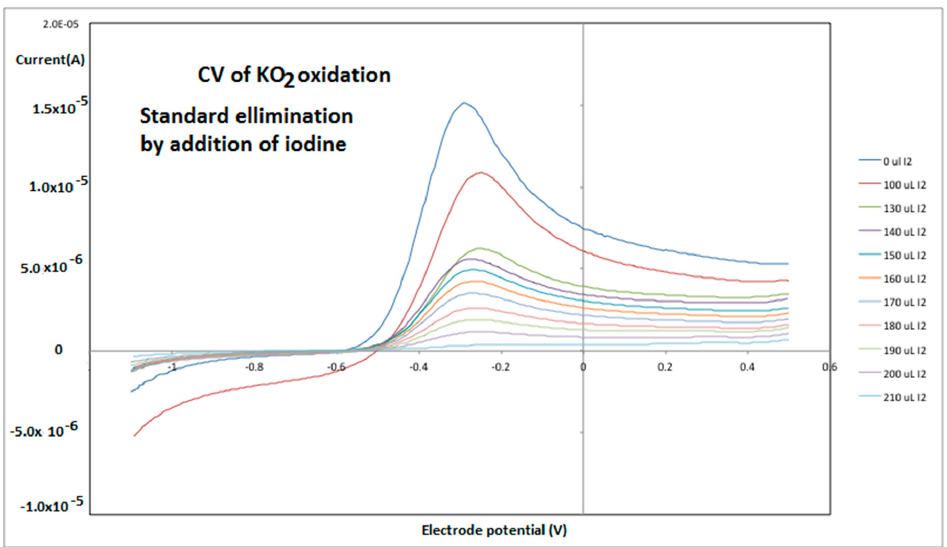
Figure 4. Voltammogram of KO 2 in DMSO with additions of iodine in ethylbenzene. The electrode